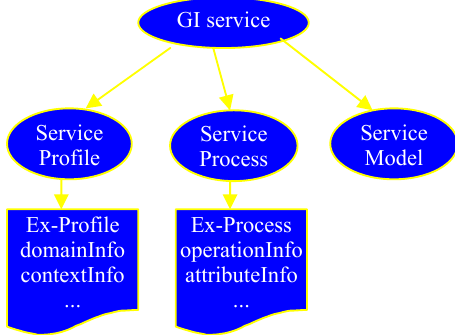
Figure 1 Extend OWL-S model for GI services